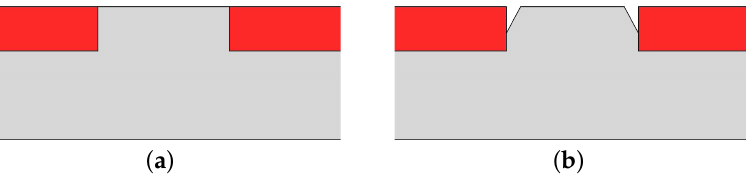
Figure 2. Comparison of CP structures. ( a ) Regular CP structure; ( b ) Chamfered CP